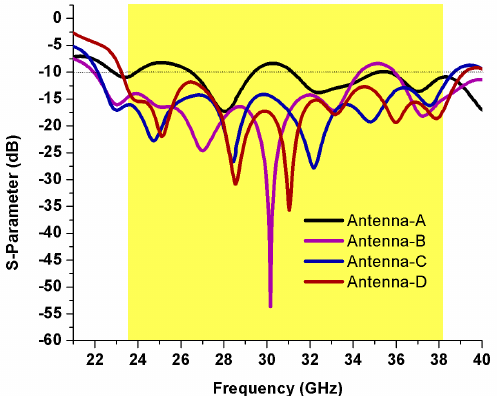
Figure 5. Reflection coefficient comparison of the different geometrical design evolution